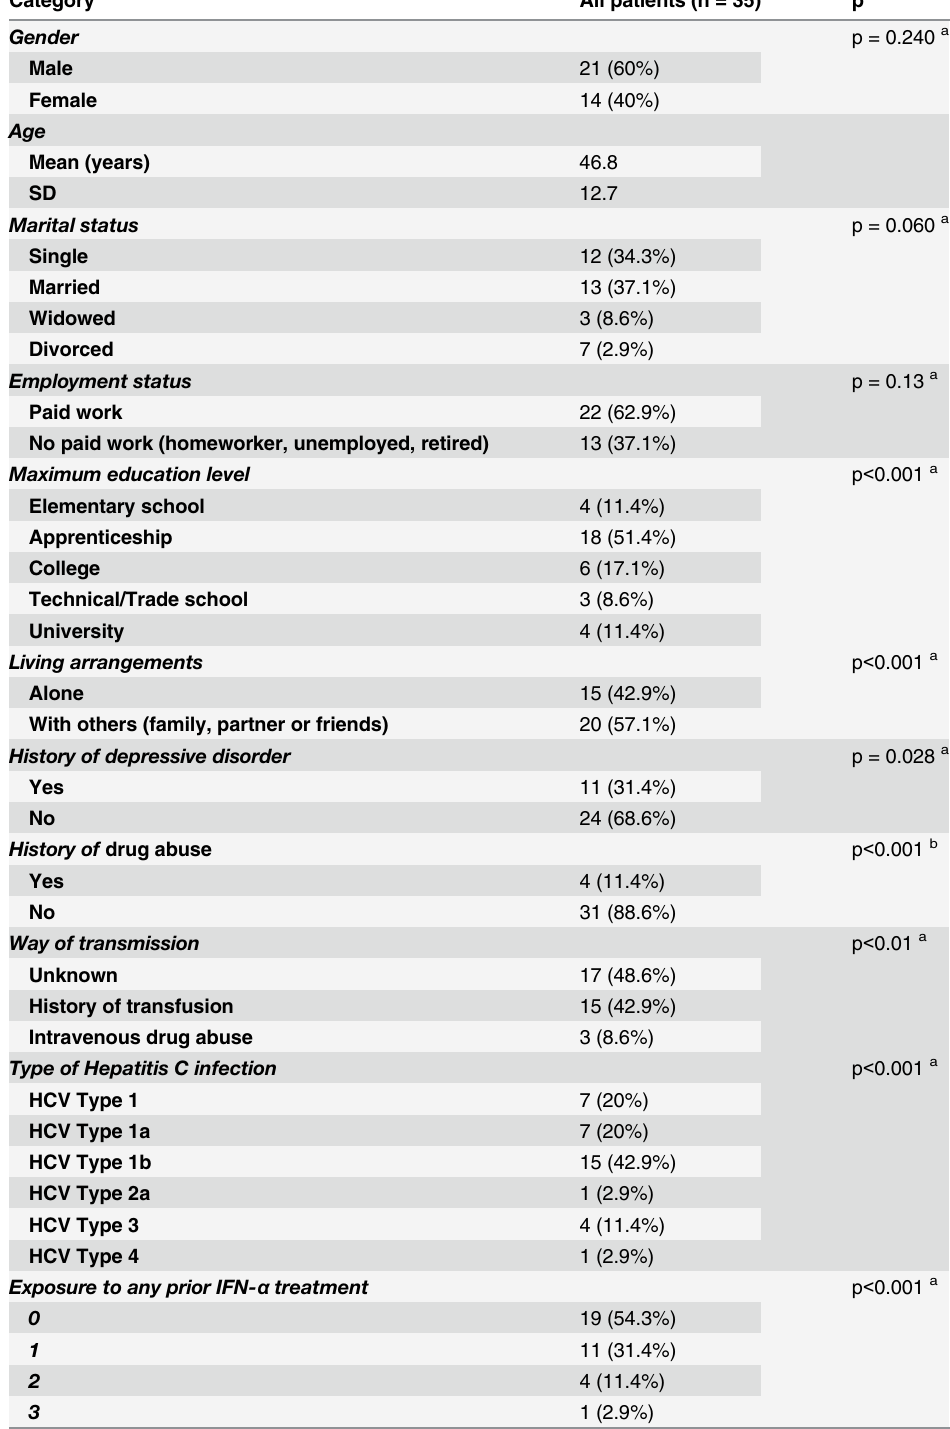
Table 1. Sociodemographic and treatment